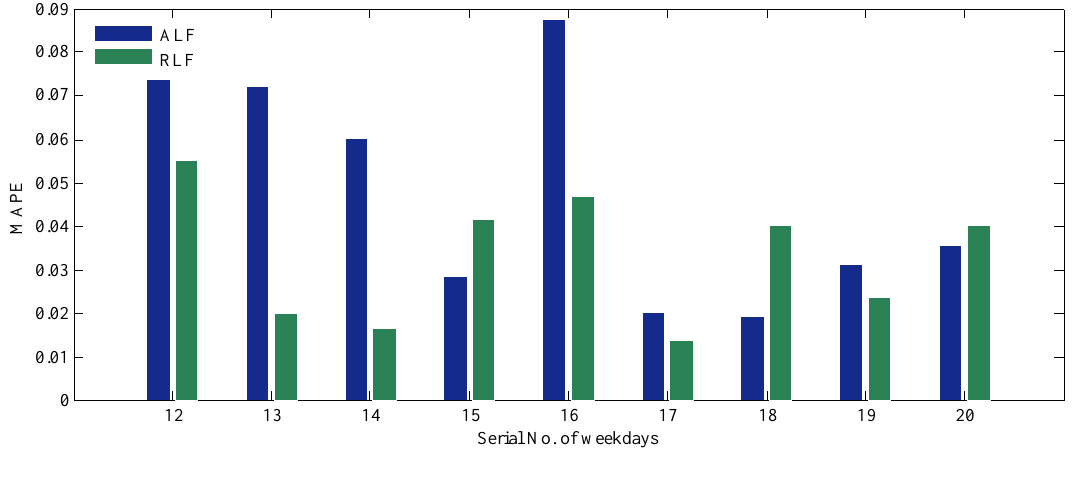
Figure 5. Forecasting results for loads of weekdays.